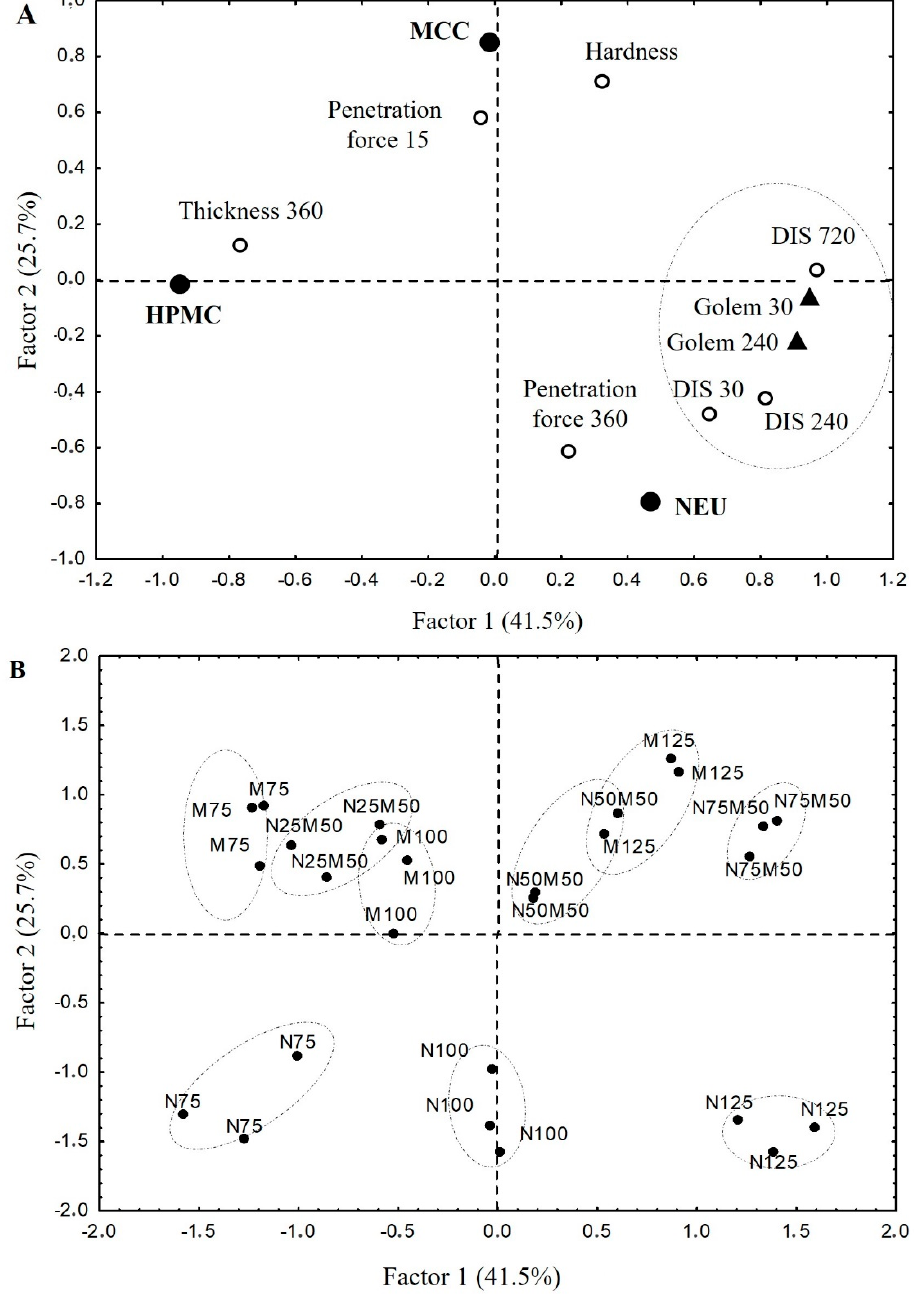
Figure 8. PCA loadings and scores plot: ( A ) PCA loadings plot; model depicts following variables: tablet hardness; drug amount released in 30 min = burst effect ; drug amount released in 240 and 720 min; the gel layer thickness after 360 min swelling; penetration force in 15 and 360 min; ( B ) PCA scores plot; model shows a layout of the evaluated samples.